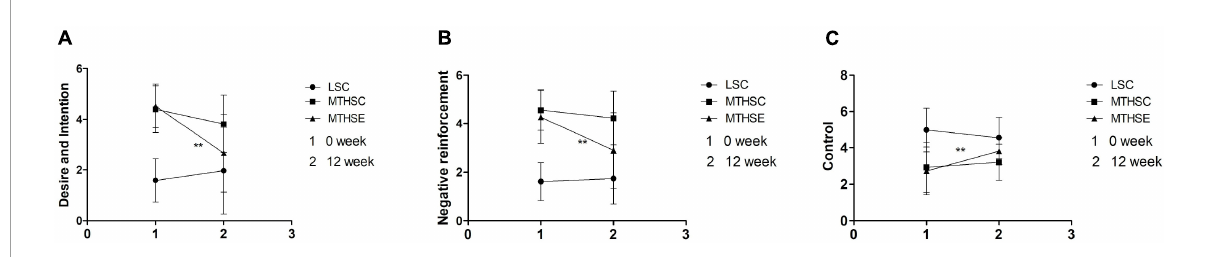
FIGURE4 Comparison of desires for drug questionnaire (DDQ) scores pre-exercise and post-exercise. 1, Week 0 is the score of “Desire and Intention”, “Negative reinforcement” and “Control”; 2, Week 12 is the score of “Desire and Intention”, “Negative reinforcement” and “Control”; Desire and Intention, desire for heroin; Negative reinforcement, repeated use of heroin to relieve withdrawal symptoms; Control, the ability to control heroin; ** p < 0.01 , compared with Pre-intervention.